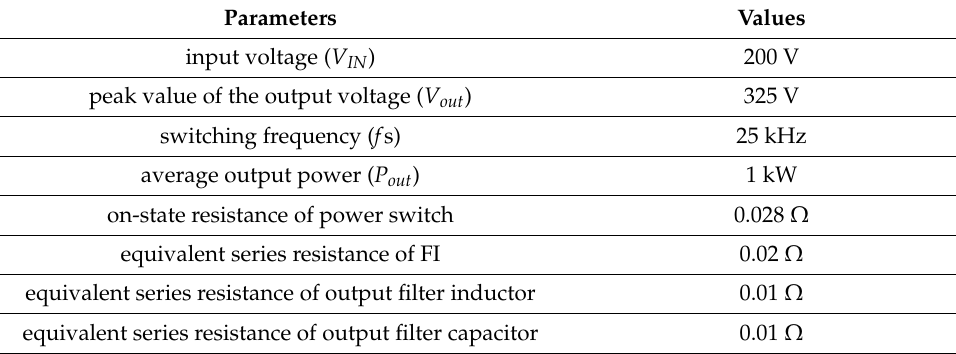
Table 3. Parameters for power loss